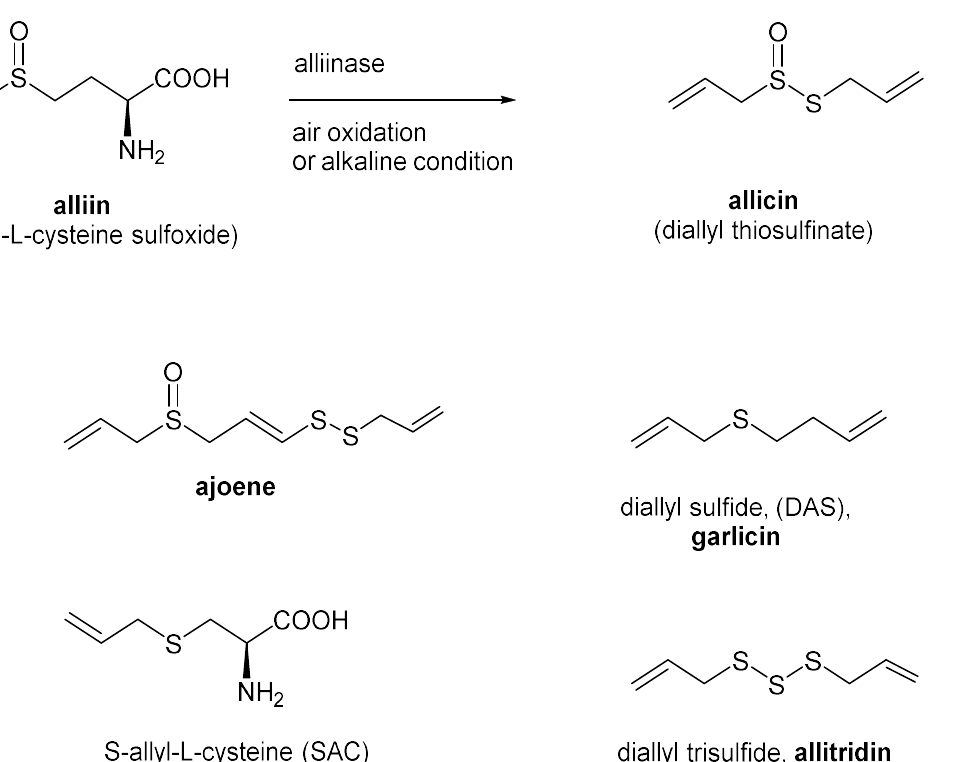
Figure 2. Structures of the organo-sulfur compounds, the active components of garlic oil.